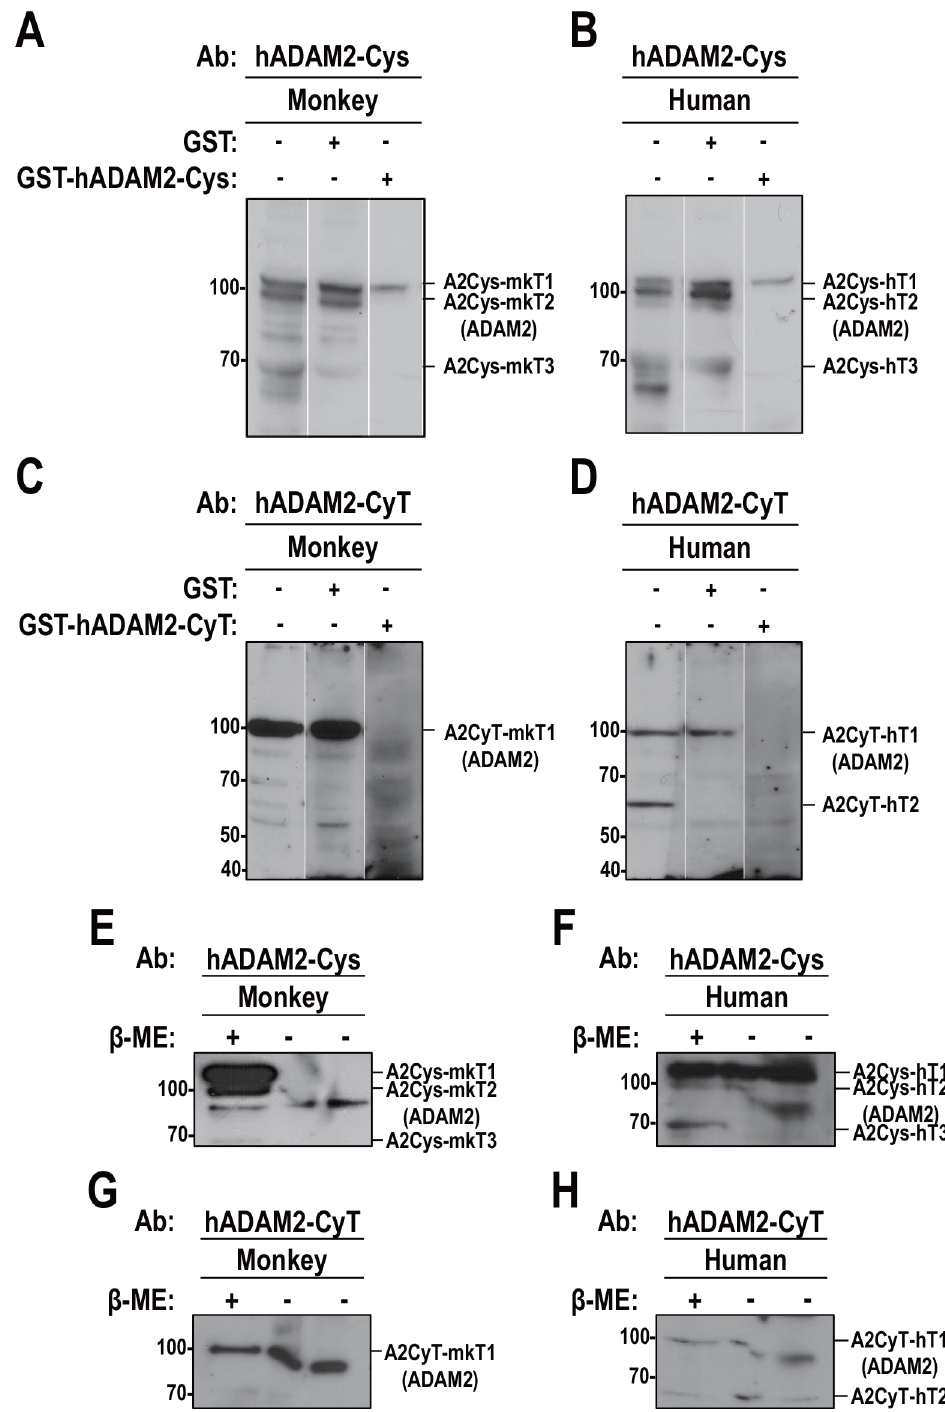
Fig 4. Specificity of the generated antibodies against human ADAM2. A and C . Testicular germ cells were isolated from monkey testis, boiled in 3% SDS and 5% β -mercaptoethanol, subjected to SDS-PAGE, and blotted with A . anti-hADAM2-Cys and C . anti-hADAM2-CyT antibodies. B and D . Human testis was lysed with 0.1% NP-40 buffer, and Western blot analysis was performed using B . anti-hADAM2-Cys and D . anti- hADAM2-CyT. Glutathione S-transferase or GST recombinant ADAM2 (GST-hADAM2-Cys and GST- hADAM2-CyT) proteins were added to the buffer containing the primary antibodies during Western blot analysis. E and G . The supernatants from the monkey testis lysates were boiled in 3% SDS with (lane 1) or